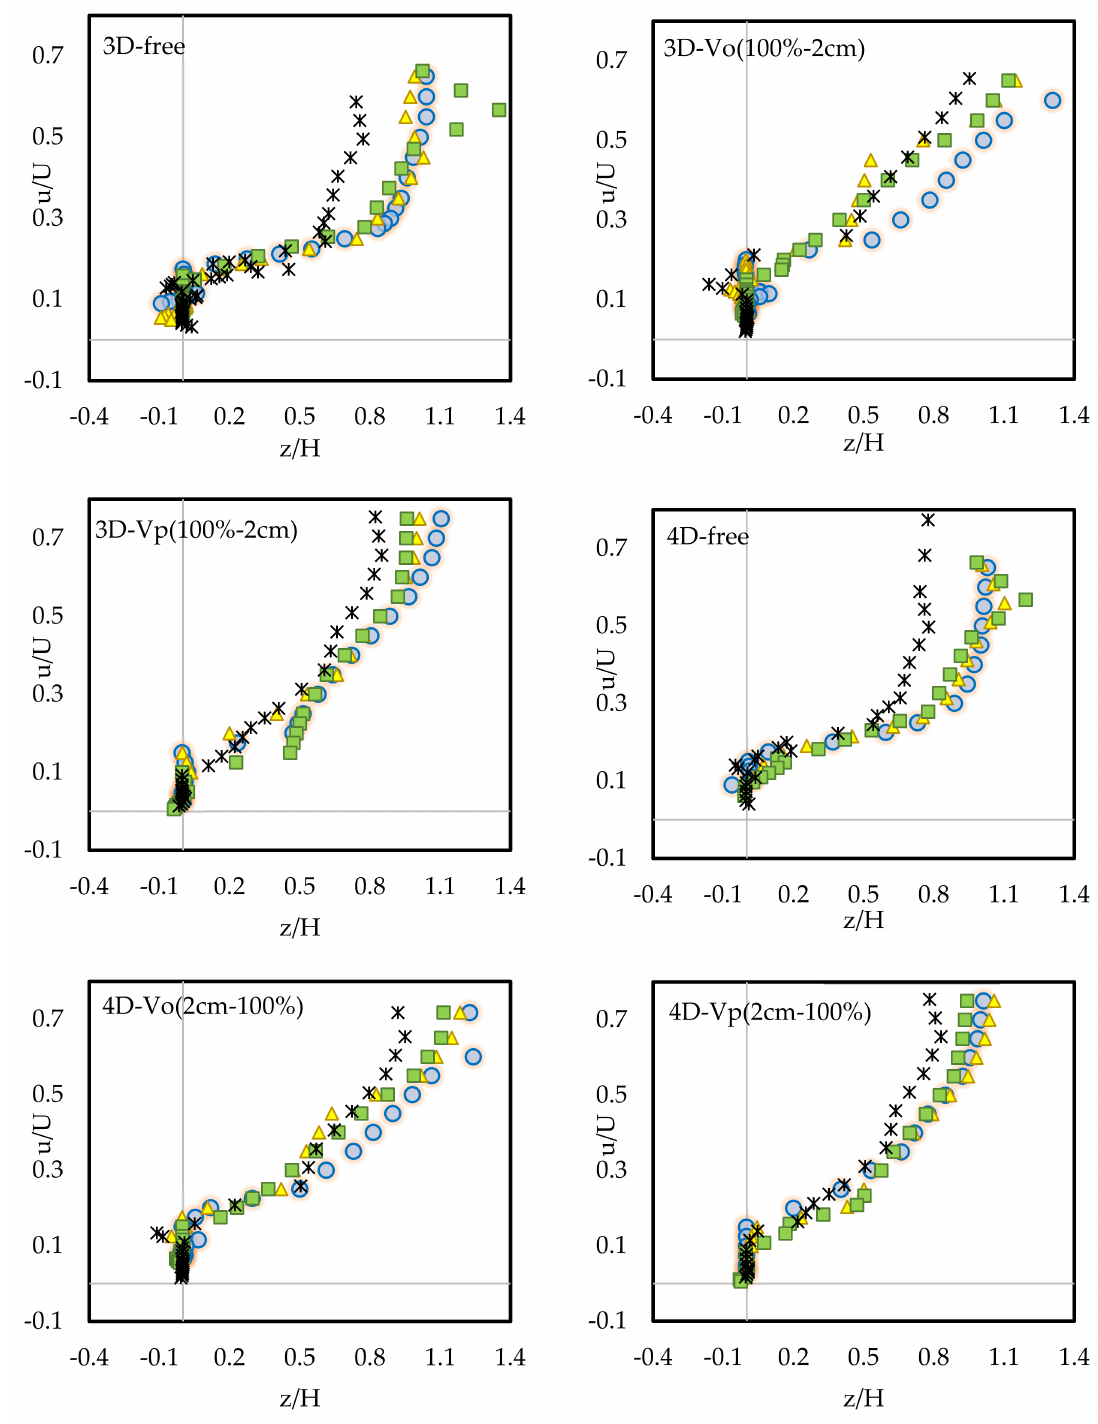
Figure 7. The values of longitudinal velocity profiles upstream of the first pile (horizontal and vertical axis are